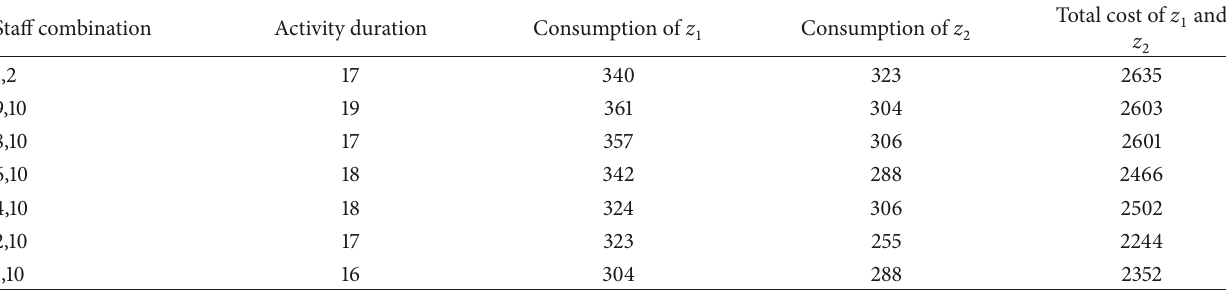
Table 7: The feasible mode set of staff combinations of b 11 .